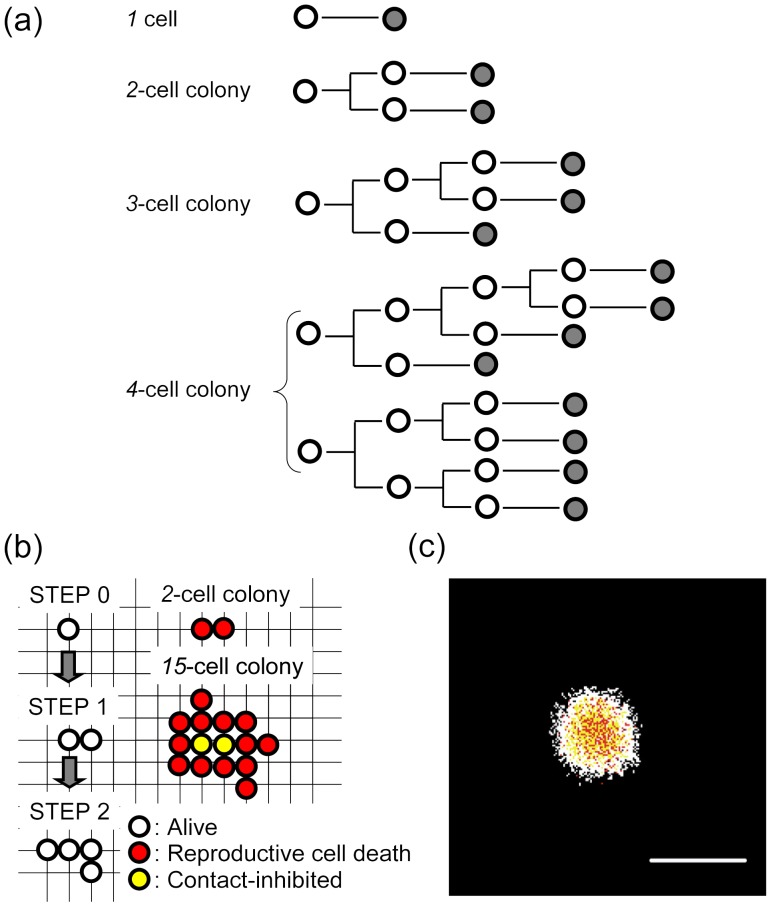
Outline of the branching dynamics model.(a) Example cell lineage of abortive colonies. (b) Illustration of colony formation in the two-dimensional colony expansion using the Monte Carlo method. Firstly, a cell was located on the grid point of which size was set as 31.6 µm×31.6 µm (a cell size of 1,000 µm2). Only when a cell has a free space in adjacent grid points, the cell can divide or move. In contrast, a cell without adjacent space cannot proliferate (by contact inhibition). (c) An example image of a simulated colony. Scale bar, 2,000 µm.